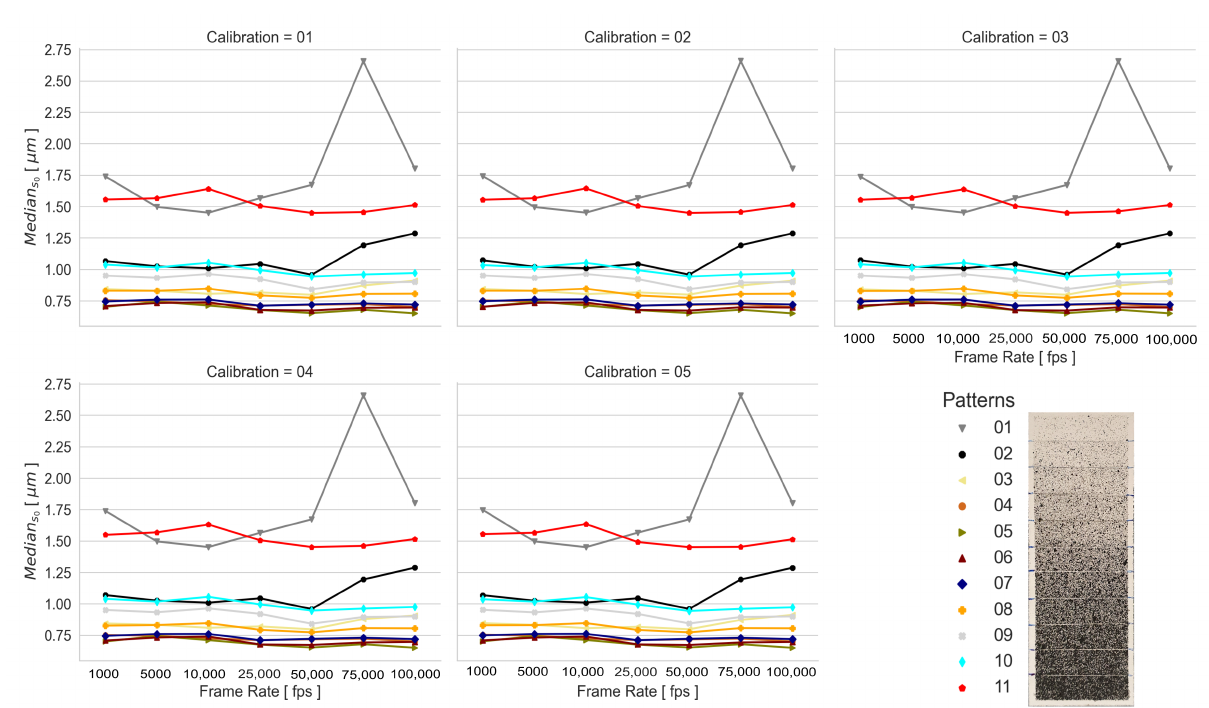
Figure A1. Median s 0 of the transformations obtained from the static RP experimental configurations.